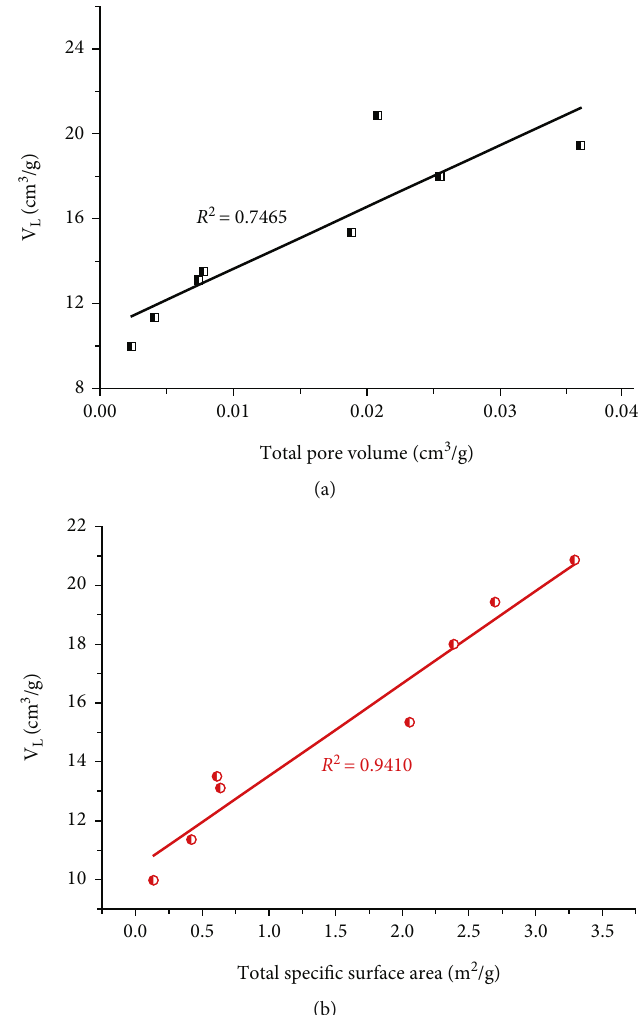
Figure 9: Correlations between the maximum methane adsorption capacity and total pore volume (a) and total speci fi c surface area